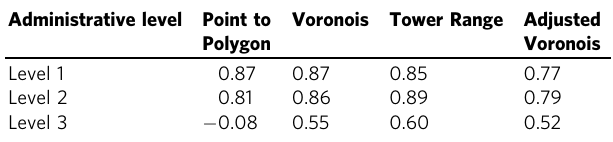
Table 3 Results of Kendall ’ s tau-b rank test, comparing the order in which the administrative units are ranked by census-based population density fi gures against how the same units are ranked using user density fi gures derived from each CDR distribution